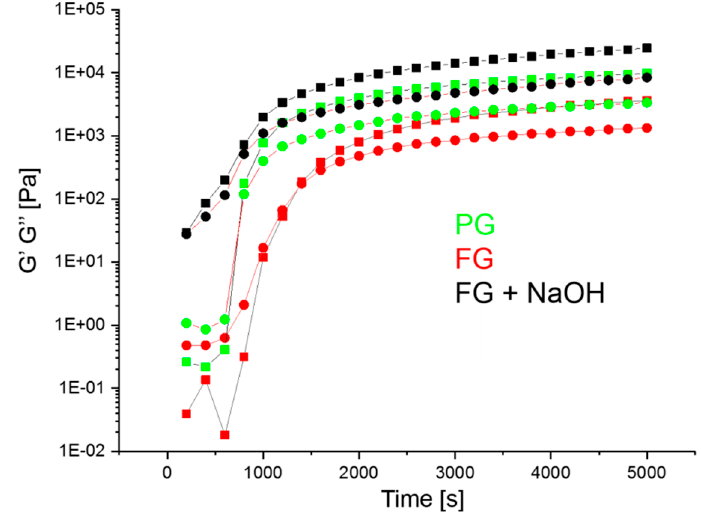
Figure 1. Time dependence of storage modulus G’ (square) and loss modulus G” (circle) of PG (green curves), FG (red curves), and FG+NaOH (black curves) solutions.